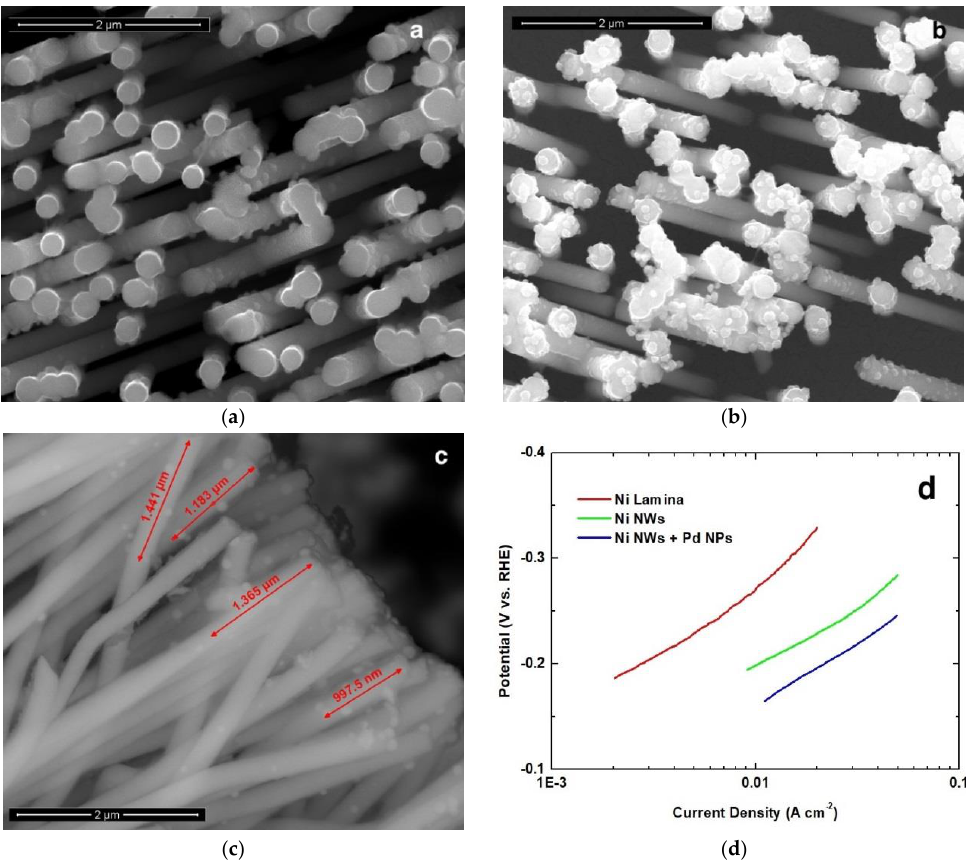
Figure 6. SEM image of Ni NWs with Pd nanoparticles obtained ( a ) after 1 min a and ( b ) 5 min of galvanic displacement deposition ( c ) cross-sectional view of sample of Figure 6a; ( d ) QSSP of Ni NWs without and with Pd nanoparticles. For comparison, the behavior of Ni sheet was reported as well.